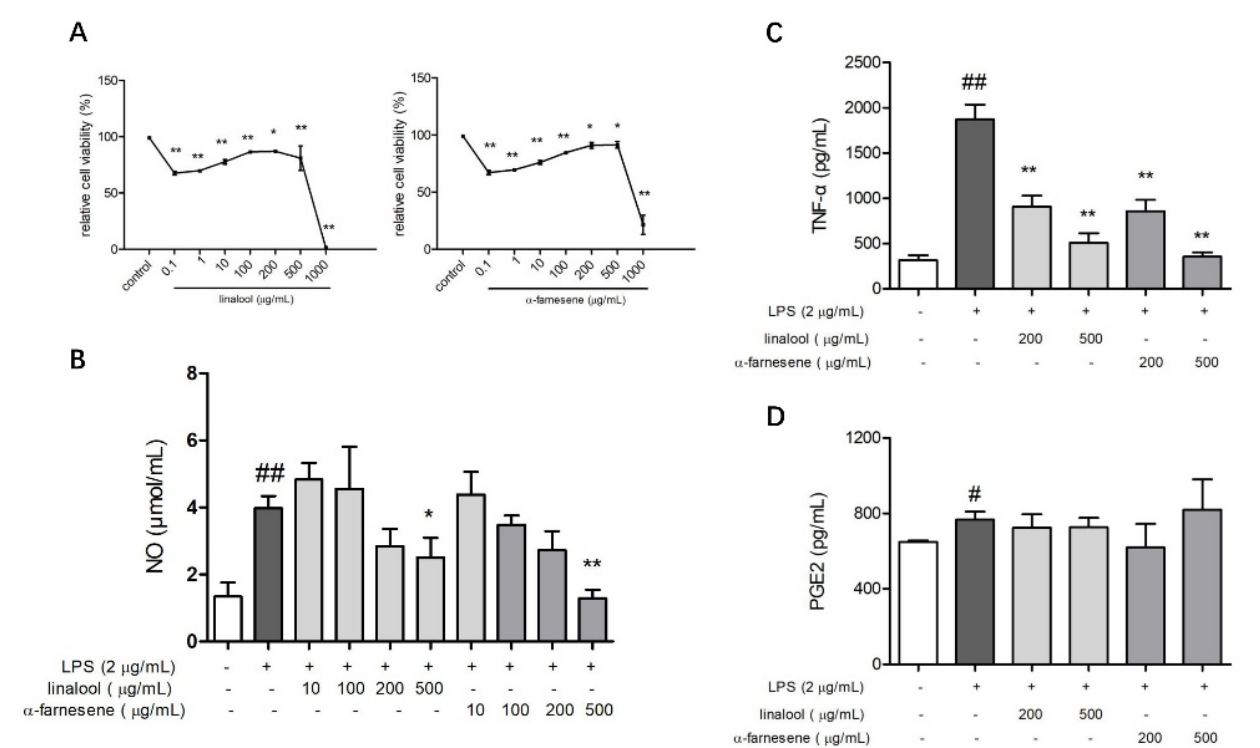
Figure 6. Effects of linalool and α -farnesene on the viability ( A ), NO secretion ( B ), and expression of TNF- α ( C ) and PGE2 ( D ) in MH-S cells. Values represent the mean ± SD from three or four independent experiments, * p < 0.05 vs. the control treatment, ** p < 0.01 vs. the control treatment in Figure 4A; * p < 0.05 and ** p < 0.01 vs. the control treatment group with LPS, # p < 0.05 and ## p < 0.01 vs. the control treatment group without LPS in Figure 4B–D. One-way ANOVA was used, and Duncan test was used for post hoc analysis.